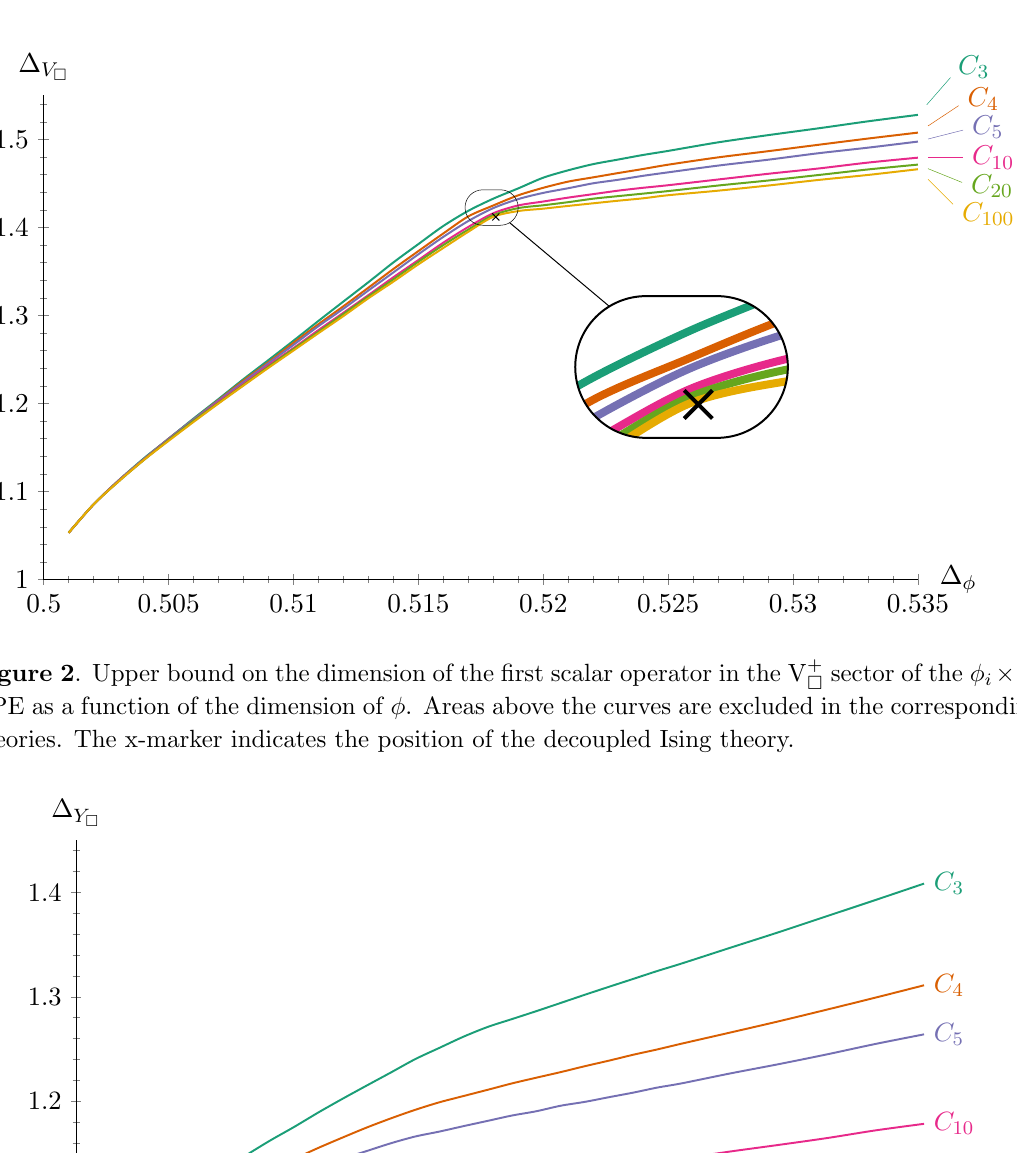
Figure 3 . Upper bound on the dimension of the (cid:12)rst scalar operator in the Y + OPE as a function of the dimension of (cid:30) . Areas above the curves are excluded in the corresponding